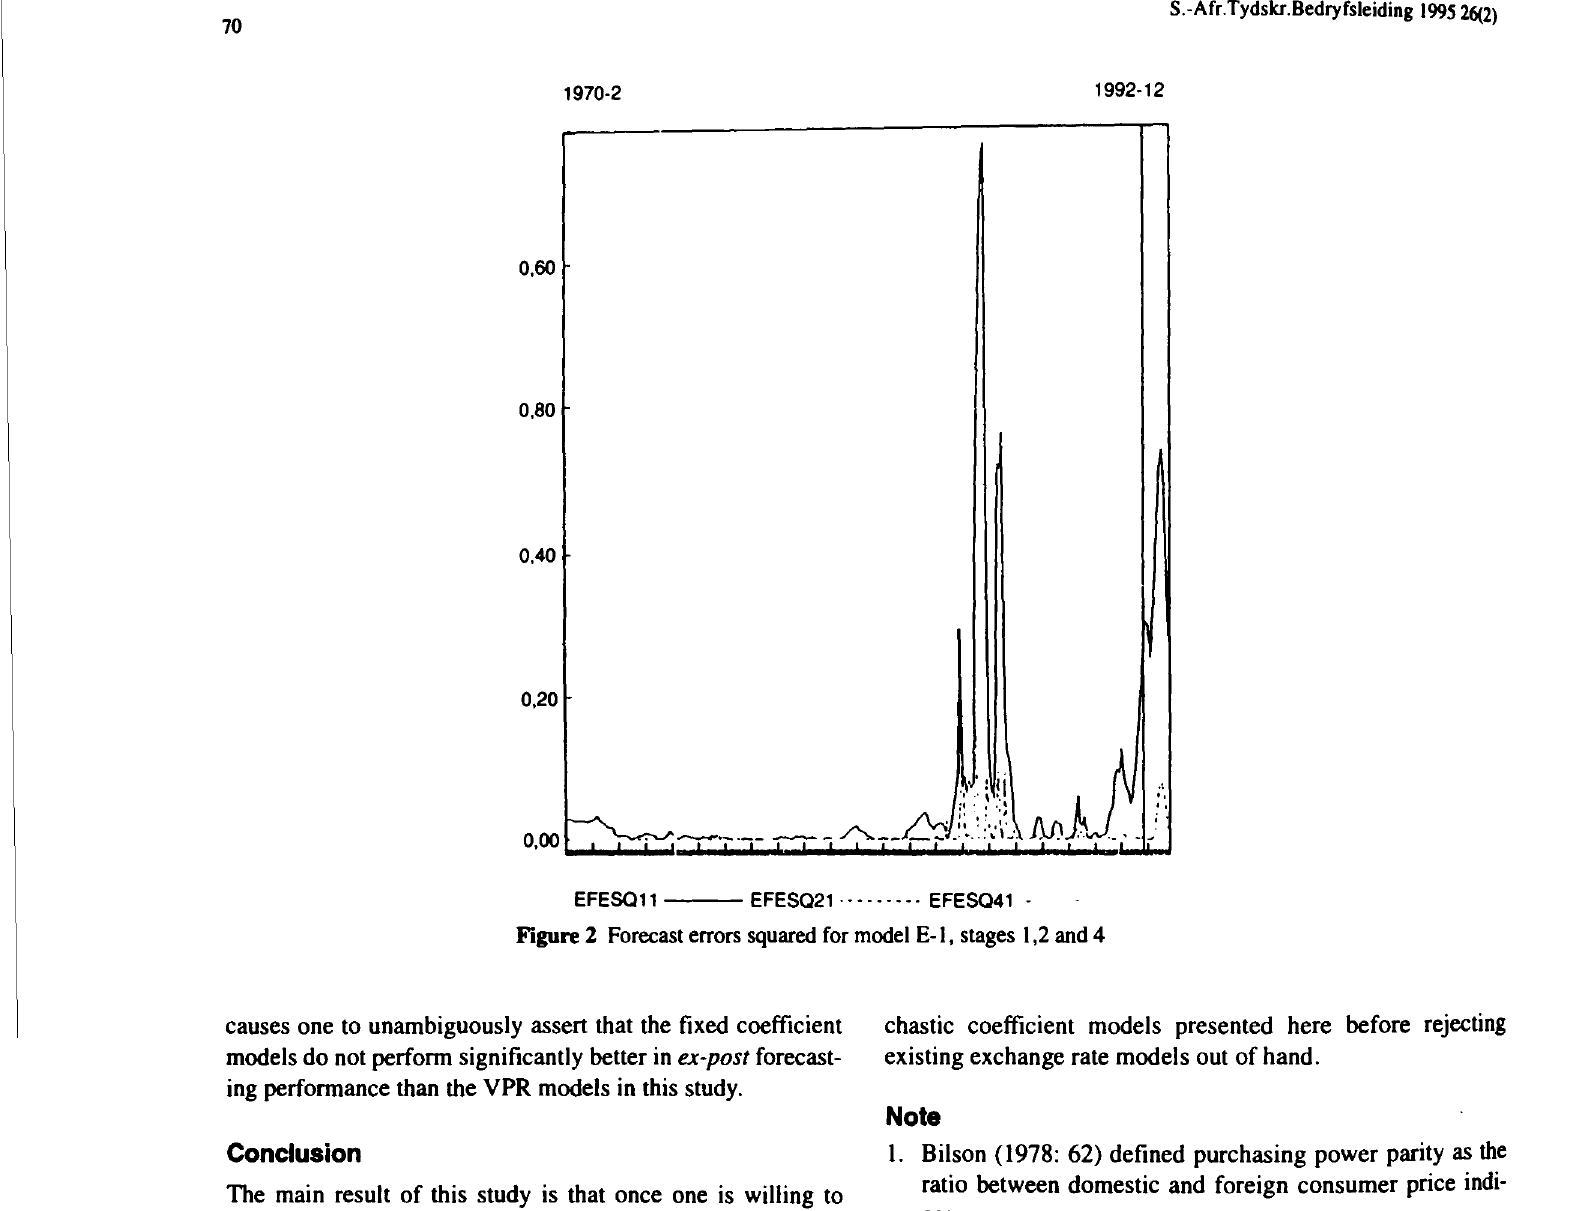
Figure 2 Forecast errors squared for model E-1, stages 1,2 and